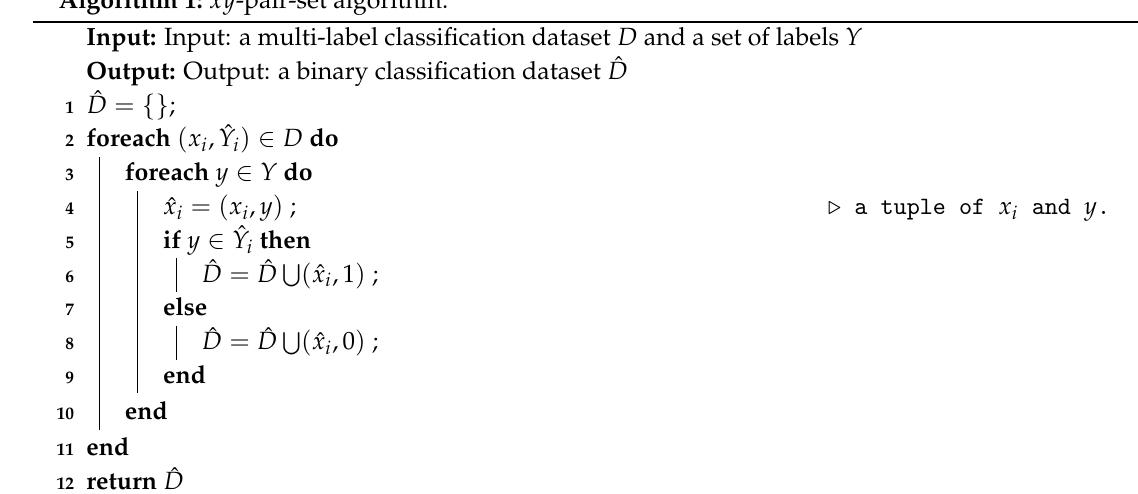
Algorithm 1: xy -pair-set